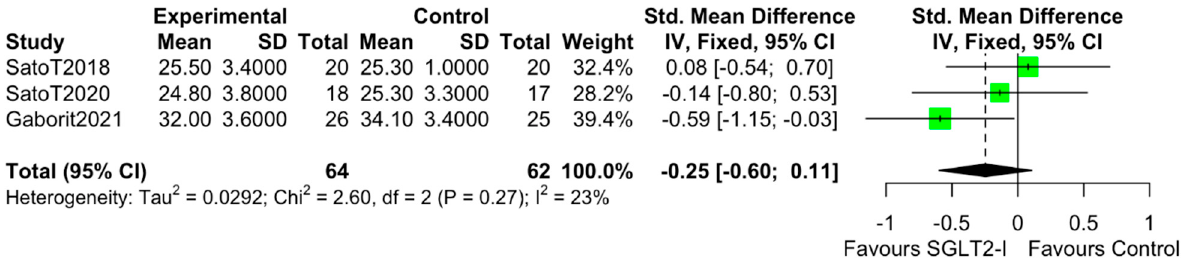
Figure 2. Effect of SGLT2 inhibitor therapy on epicardial adipose tissue (EAT). Random − effects, standardized mean difference (SMD), 95% confidence intervals (CI), and I2 statistics.